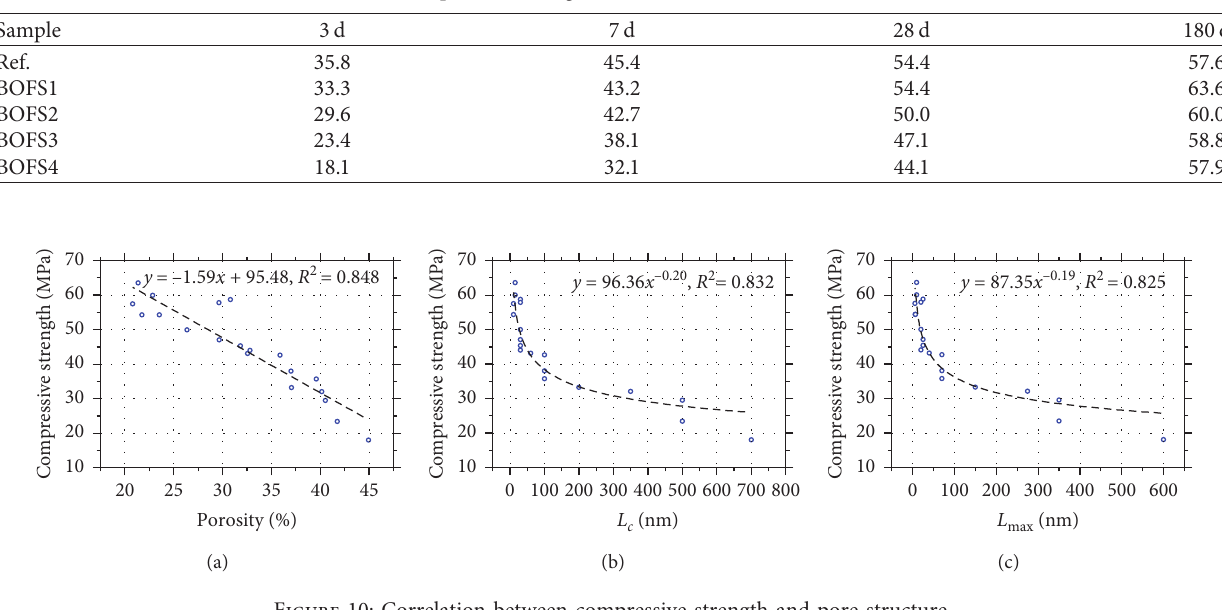
Table 6: Compressive strength of BOFS-blended mixtures (MPa).